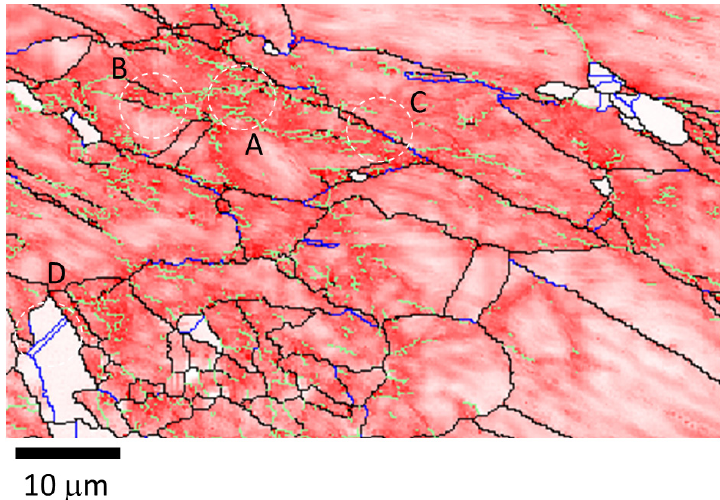
Figure 8. Magnification image of KAM map extracted from Figure 1a for 50% cold-rolled FePd alloy after 1 min annealing at 700 °C. The color code is shown in Figure